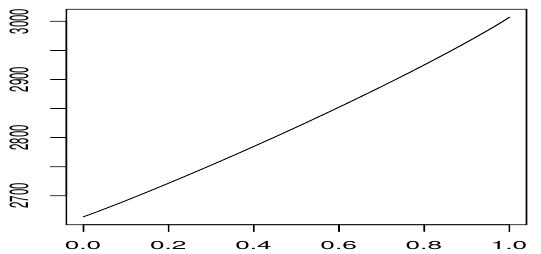
Figure 3. Value function for the state 2 depending on believe probability. The Figure 4 illustrates the choice of the optimal action for the state p = 3 depending on the believe state depicted in the same way as in Figure 3. Again the end points of the graph represent optimal actions conditioned on certainty about the current regime. As expected, the optimal decision switches from a = 2 (act) to a = 1 (be idle) at some believe probability of approximately